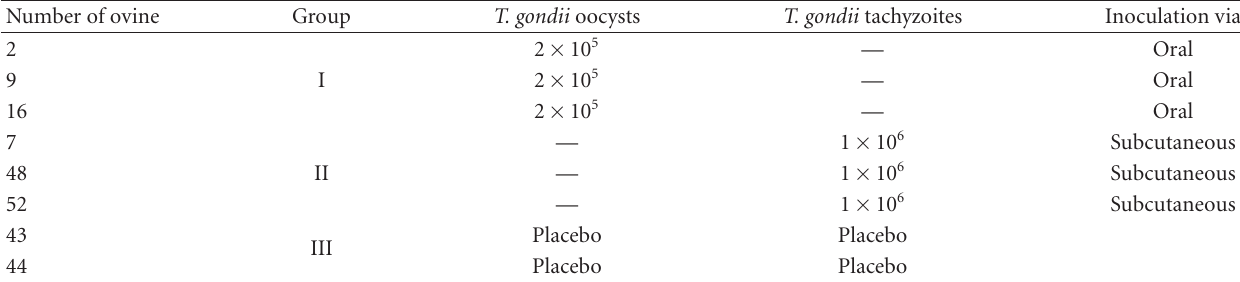
Table 1: Experimental outline of the rams inoculated with T. gondii .